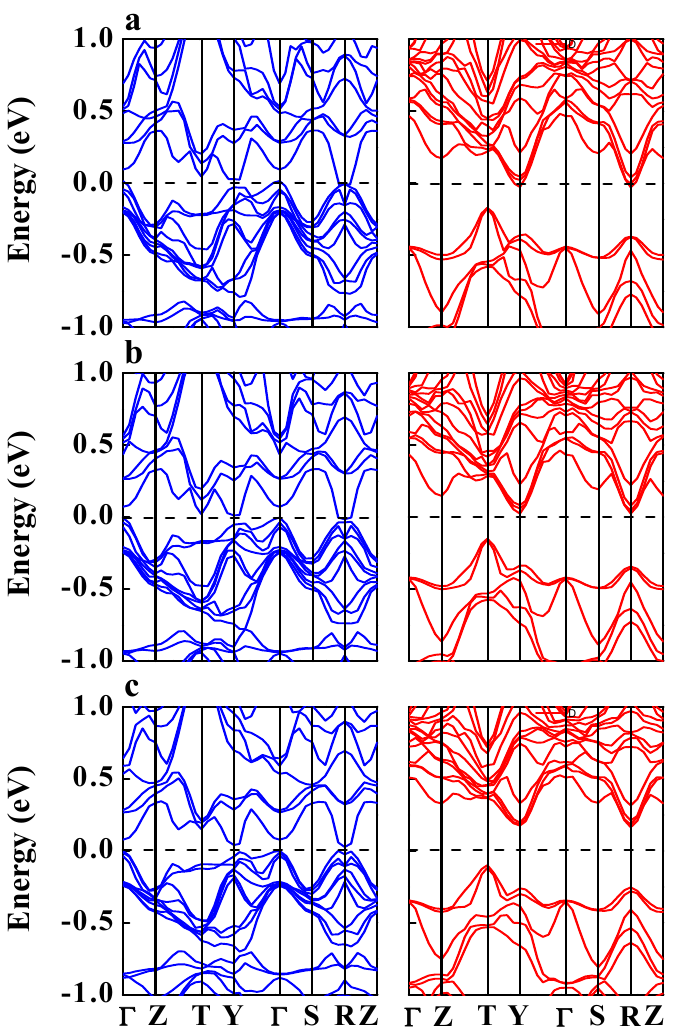
Figure 6. Spin-resolved electronic band structures of ( a ) Ti 2.25 Co 0.75 Si 0.5 P 0.5 , ( b ) Ti 2.25 Co 0.75 Si 0.5 As 0.5 , ( c ) and Ti 2.25 Co 0.75 Si 0.5 Sb 0.5 at the equilibrium lattice parameters. The zero of the energy scale is set at the Fermi energy. The blue and red solid lines represent the spin-up and spin-down states, respectively.